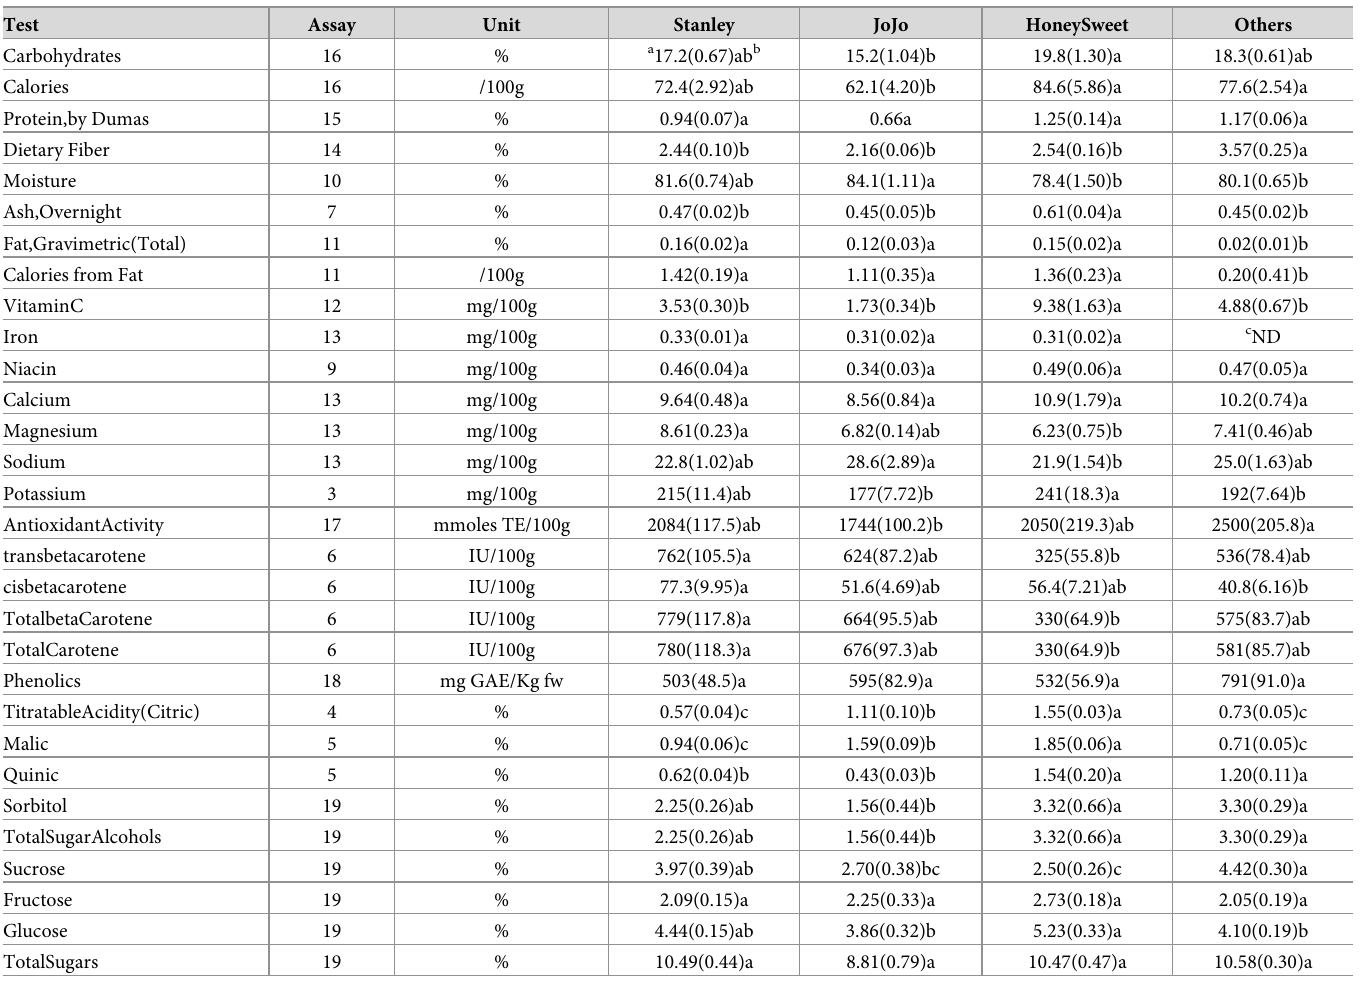
Table 2. Average values for composition of